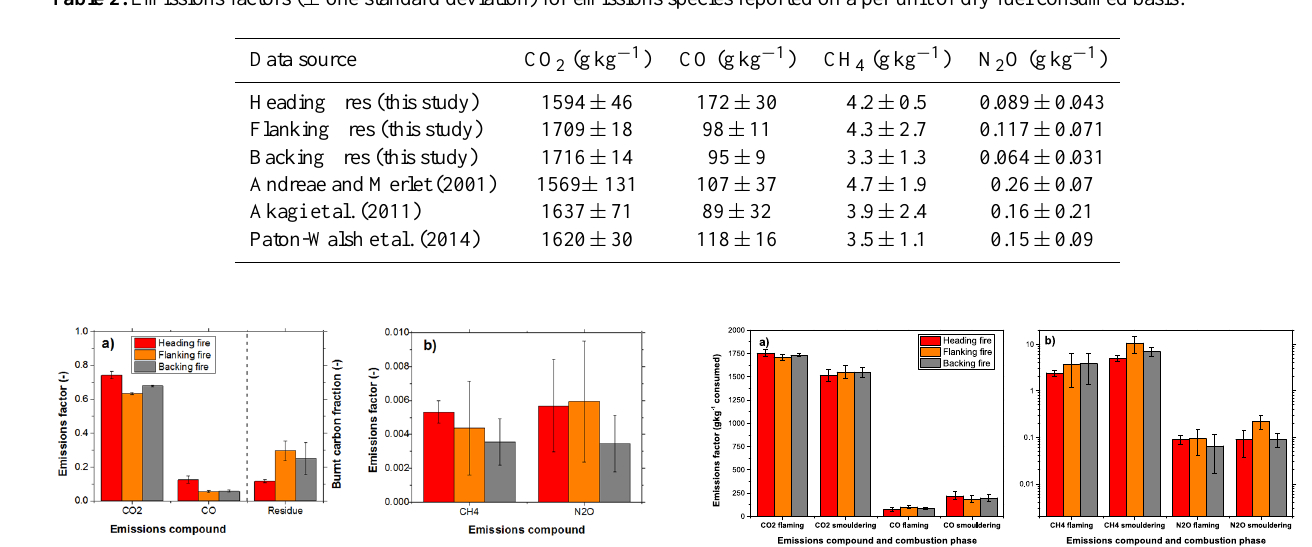
Table 2. Emissions factors ( ± one standard deviation) for emissions species reported on a per unit of dry fuel consumed basis.